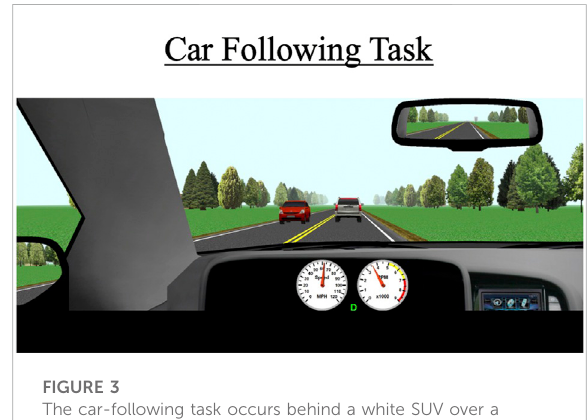
duration of 5 min. The primary outcomes for this scenario are standard deviation of lateral position (SDLP), the car ’ s modulus, and the coherence to the